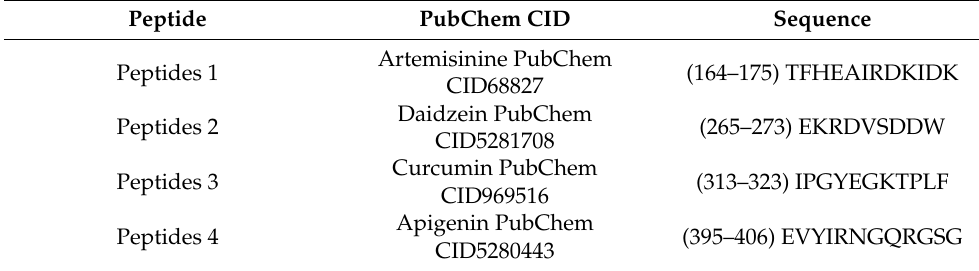
Table 2. The amino acid sequence of NADL-NS5B